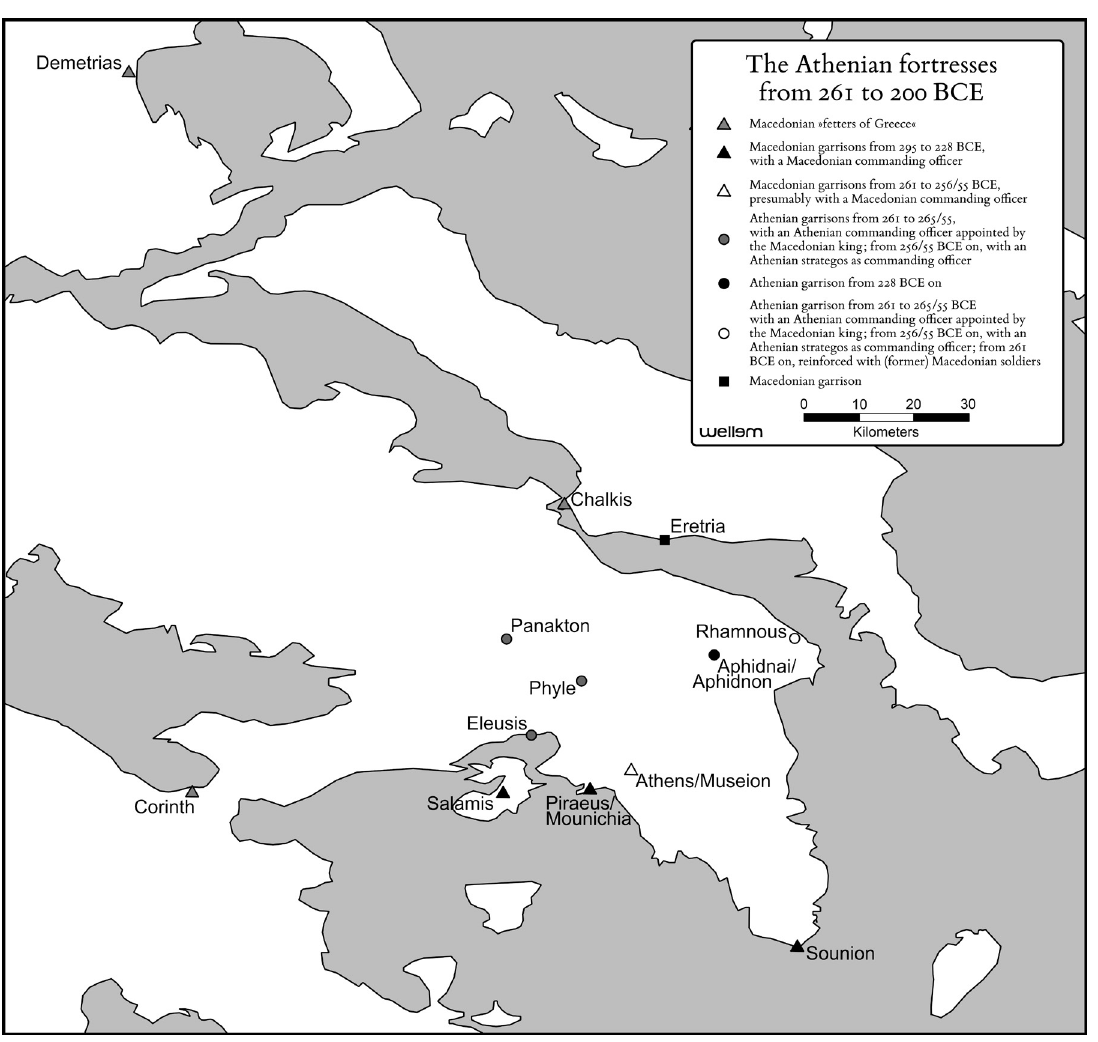
Figure 2. Map of the Macedonian garrisons (Wellem Verlag, C.